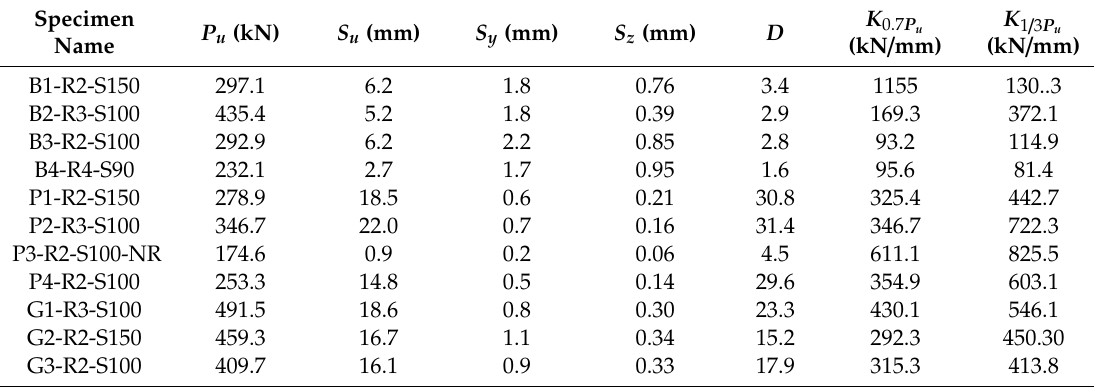
Table 3. Summary of the push-out test